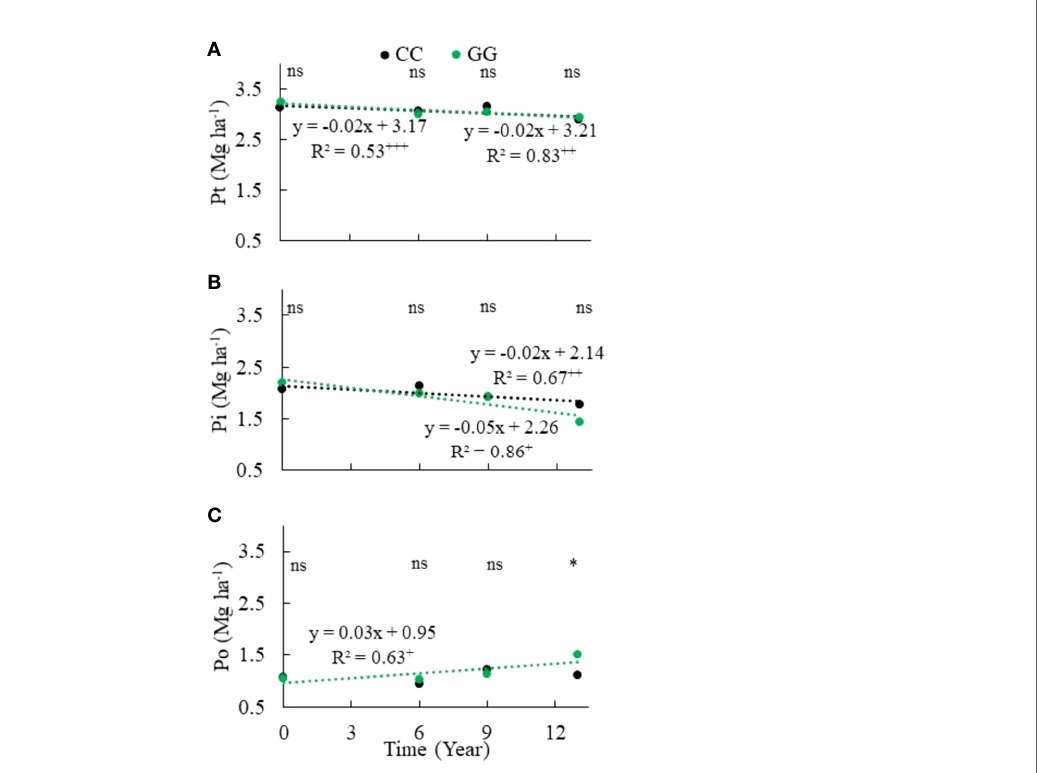
FIGURE 4 | Trends of (A) total phosphorus, (B) total inorganic phosphorus and (C) total organic phosphorus stocks in the 0-30 cm topsoil layer of soil subjected to different soil management systems. CC – permanent conventional crop rotations (corn, winter wheat, and barley crops) and GG-permanent grassland. ns Not signi fi cant. *Signi fi cant in the Scott – Knott test (p ≤ 0.05). + Signi fi cant at p ≤ 0.01. ++ Signi fi cant at p ≤ 0.05. +++ Signi fi cant at p ≤